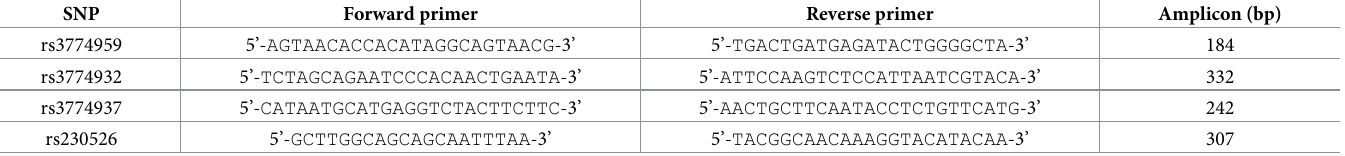
Table 1. Sequences of the PCR primers used in this